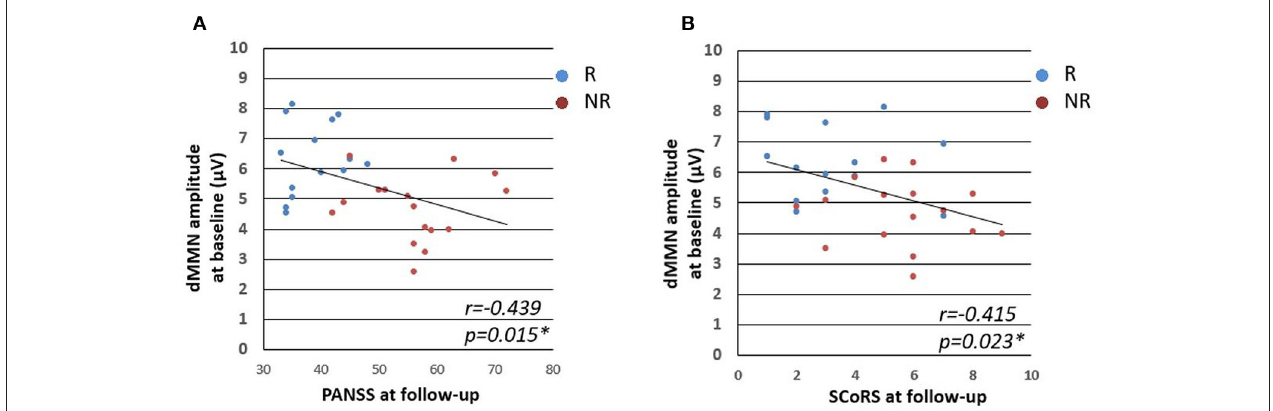
FIGURE 4 | Relationships between dMMN amplitude at baseline and clinical, cognitive, and social parameters. Figures represent PANSS total score at follow up vs. dMMN amplitude at baseline (A) and SCoRS at follow-up vs. dMMN amplitude at baseline (B) . Abbreviations: R, schizophrenia remitter; NR, schizophrenia non-remitter; dMMN, duration mismatch negativity; PANSS, Positive and Negative Syndrome Scale; SCoRS, Schizophrenia Cognition Rating